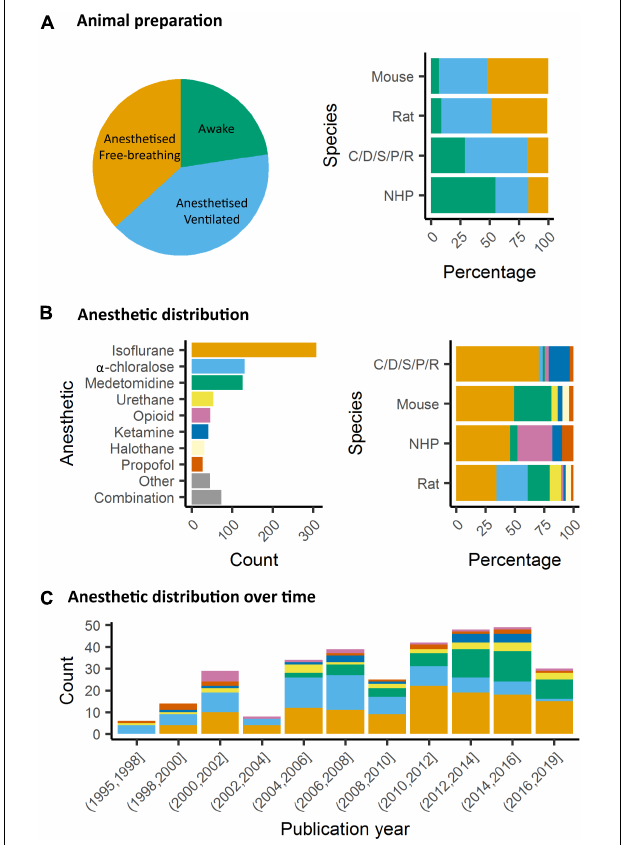
FIGURE 4 | Animal preparation and anesthesia trends. (A) Animal fMRI relies mainly on anesthesia to help restrain animals. NHP remain the major species acclimated to awake fMRI. (B) Isoflurane is the principal anesthetic used for maintenance during fMRI recordings. However, the distribution of other agents change with species. (C) Medetomidine is growing to become the second most used agent behind